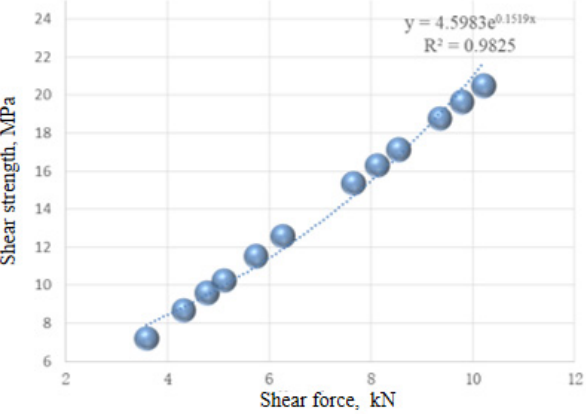
Figure 6. Correlation distribution of shear force and shear strength.